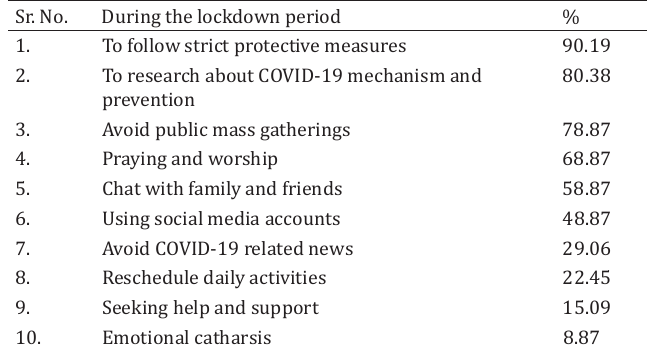
Medical and emergency and Critical Care Nursing students’ personal coping mechanisms related to COVID-19 pandemic outbreak